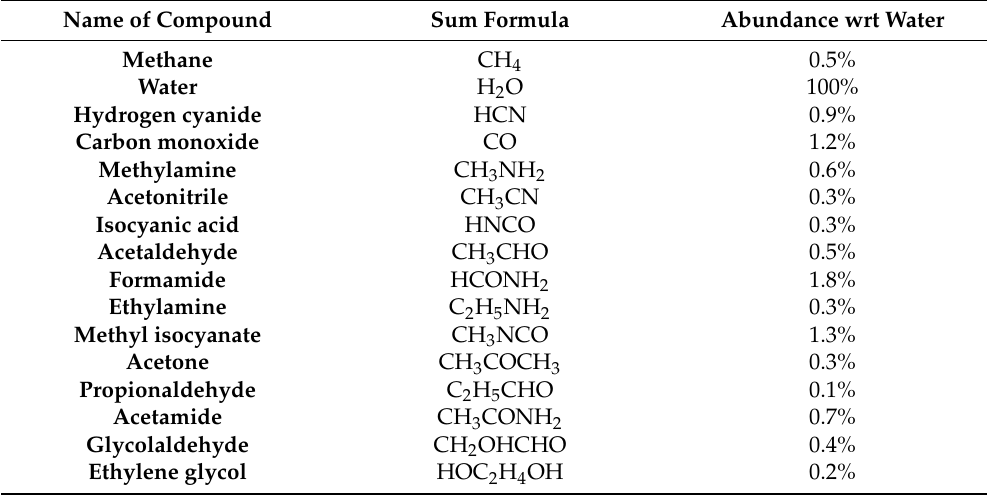
Table 1. List of molecules identified on the comet nucleus of comet 67P by the COSAC instrument [8]. Abundances are given normalized to water, which is the most abundant